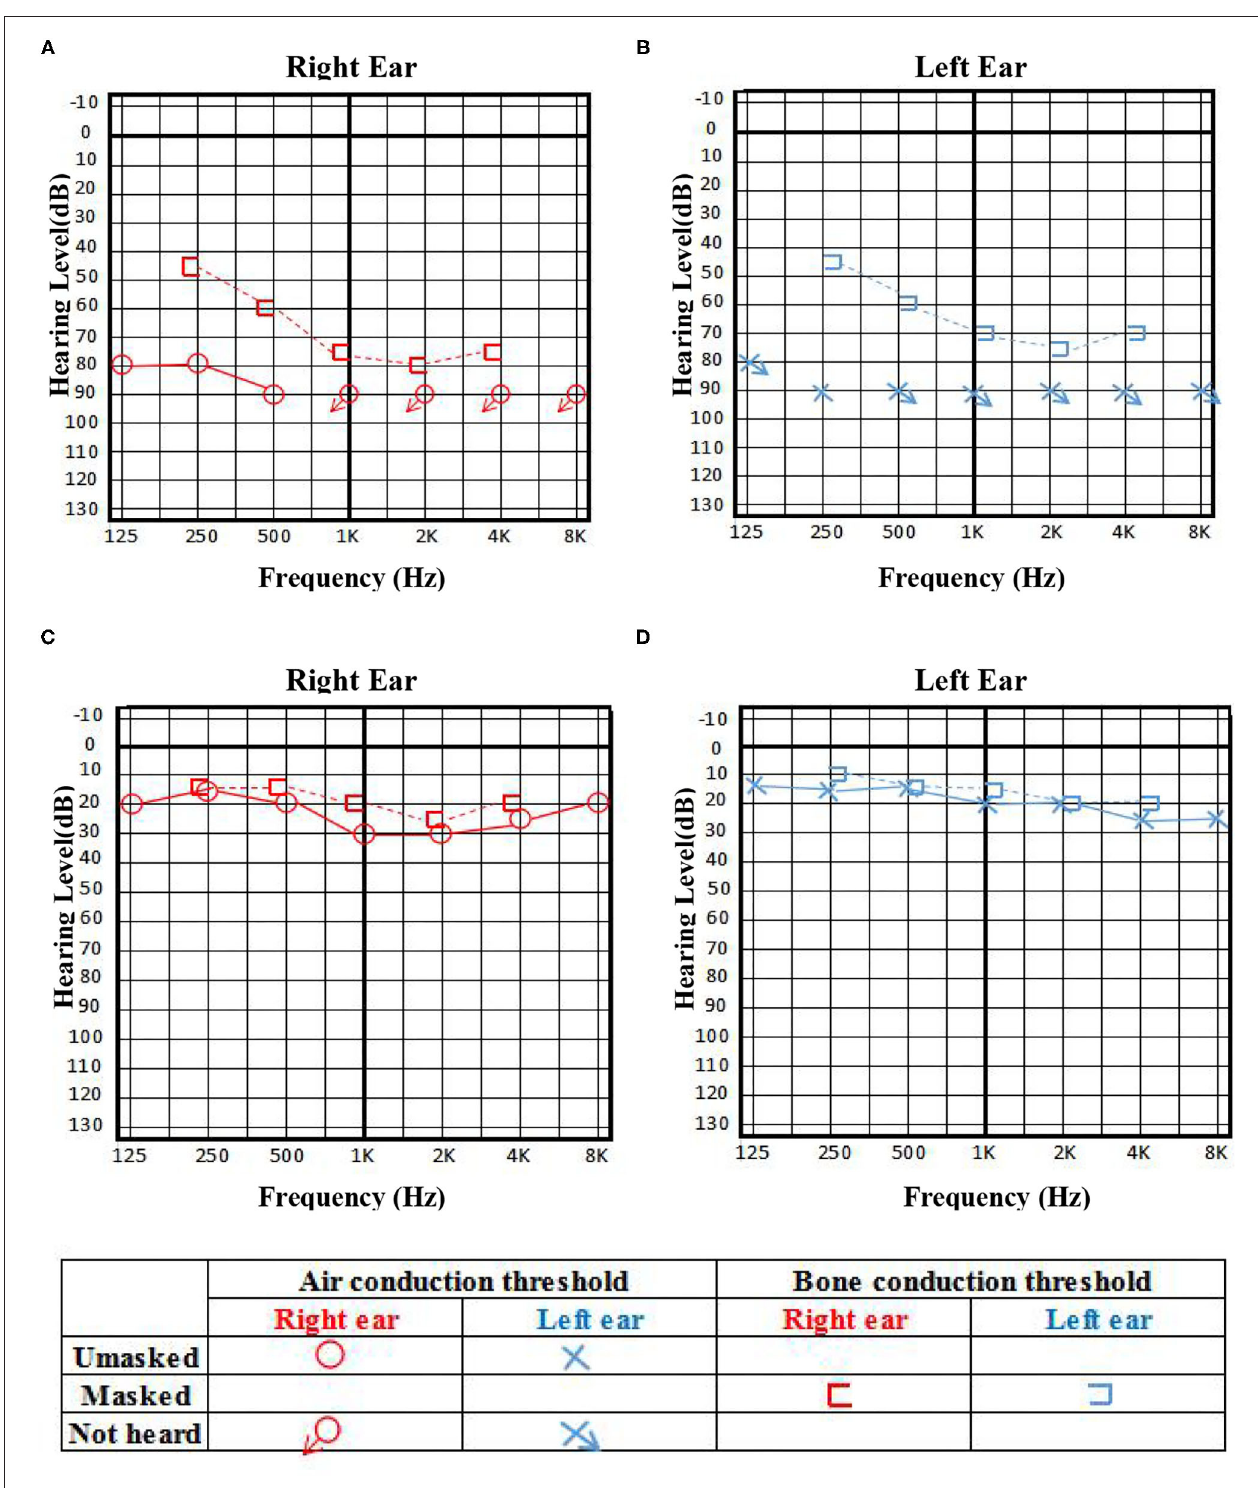
FIGURE 2 | The pure tone audiogram on admission indicated bilateral serious sensorineural hearing loss, predominantly in higher frequencies (A,B) , and achieved significant improvement 3 days before discharge (C,D) .